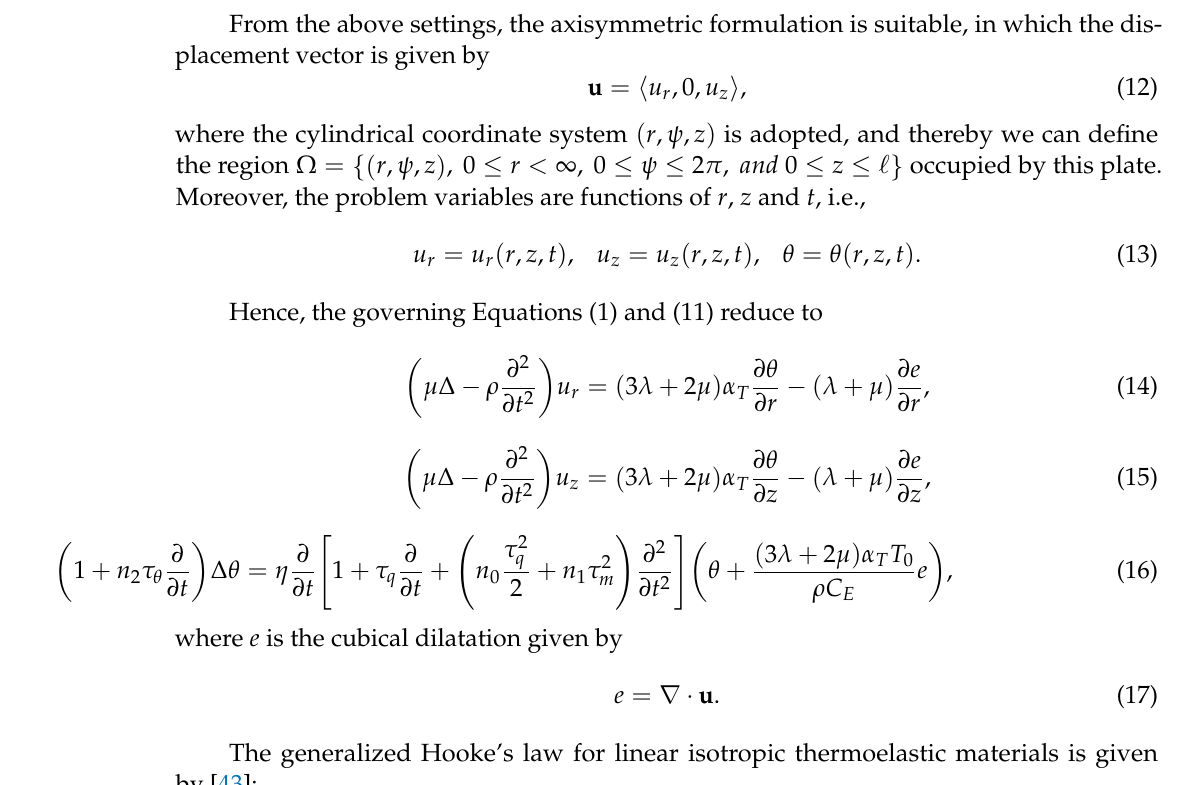
Figure 1. Problem description with prescribed thermal boundary conditions on the front and rear surfaces.